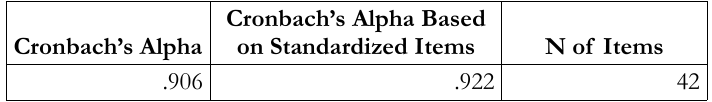
Table 25. Reliability Statistics